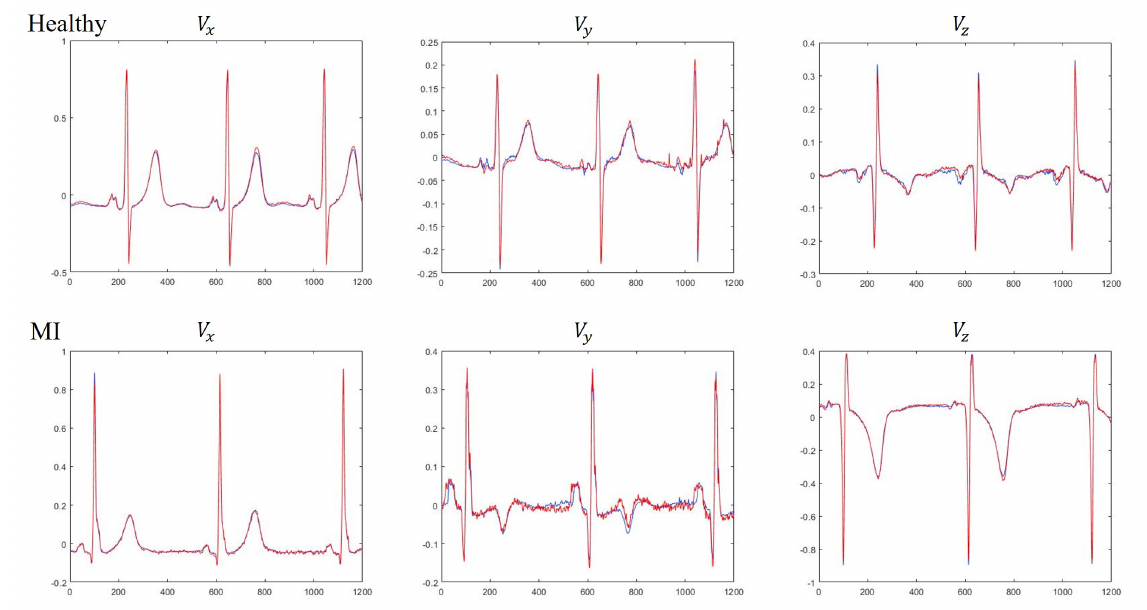
Figure 7. Comparison between measured ( blue ) and derived ( red ) Franks leads for healthy and MI